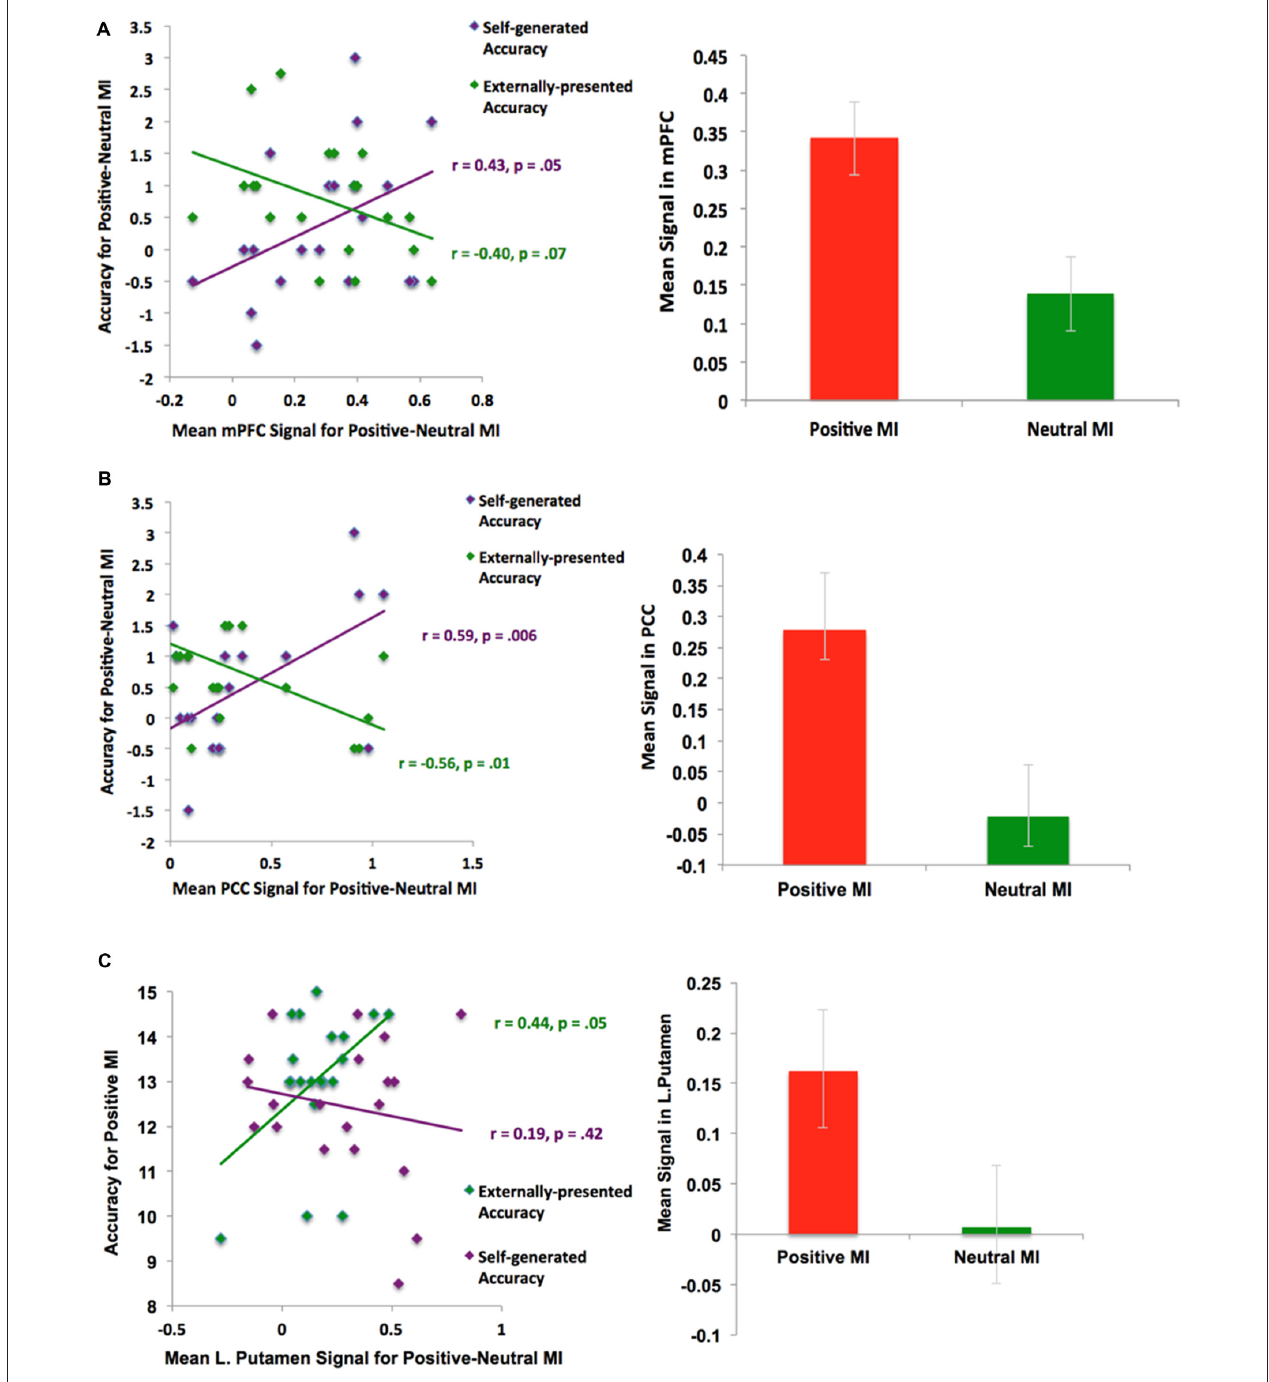
FIGURE 6 | ROI Analyses: Positive mood sensitive regions predict better reality monitoring task performance within (A) mPFC, (B) PCC and (C) basal ganglia/putamen.